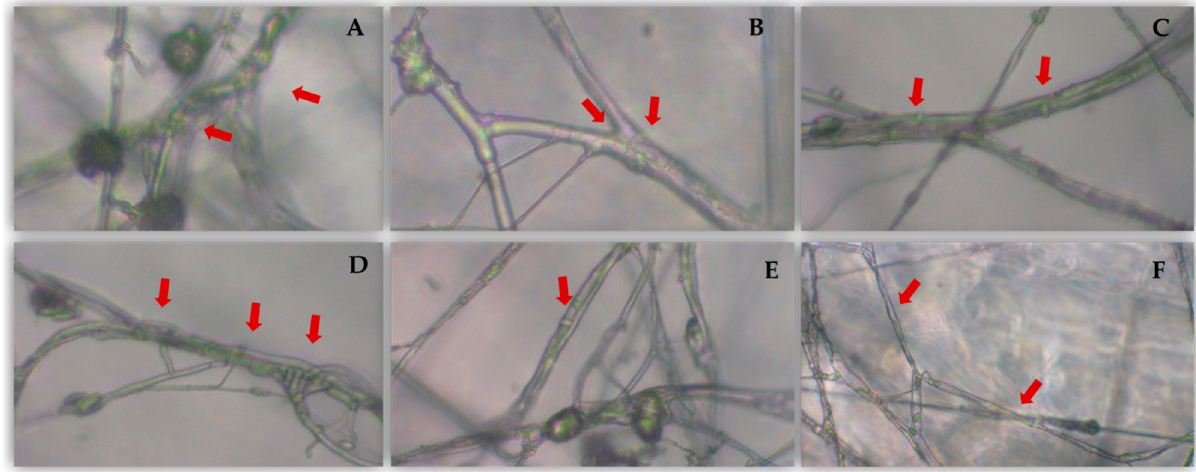
Figure 3. Mycoparasitism by Trichoderma hyphae a coiling around the hyphae ( A – E ). Hook formation ( C , E ), wrapping ( B , D ) and hyphallysis ( F ). Images were taken with a × 40 objective.